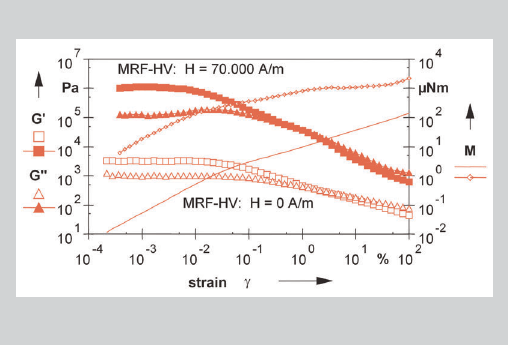
Figure 6-b (left above): Amplitude Sweep at w = 10 s -1 showing the storage modulus G’, the loss modulus G’’ and the torque M of MRF-HV with the magnetic field strength H = 0 A/m and H = 70.000 A/m. Figure 7 (right above): Magneto sweep: Oscillatory test with logarithmically increasing magnetic field strength showing storage modulus (G’) and loss modulus (G’’). Figure 8 (right below): Parallel plate sensor with MRF at the applied field strength below 10 4 A/m (Region I.).